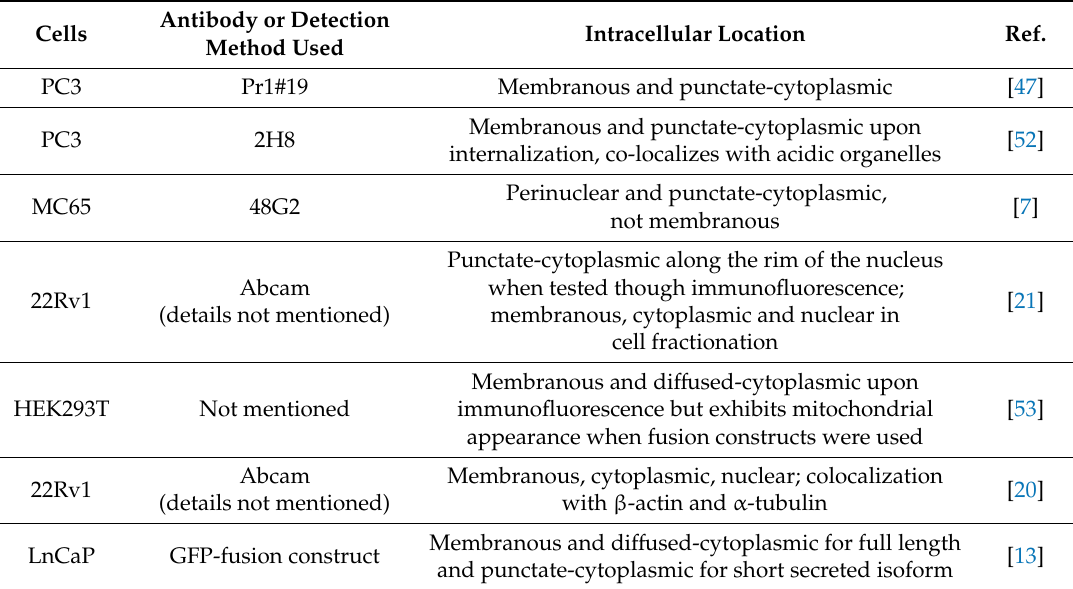
Table 2. Studies reporting TMEFF2 intracellular